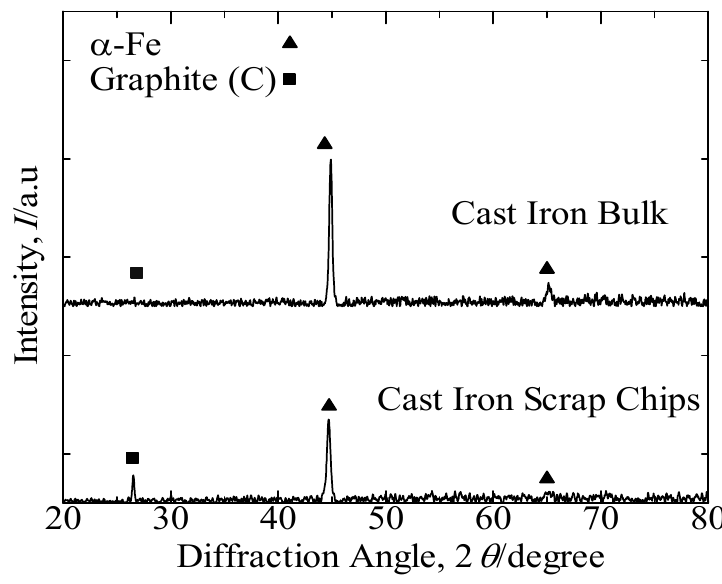
Figure 1. XRD patterns of cast iron scrap chips and cast iron